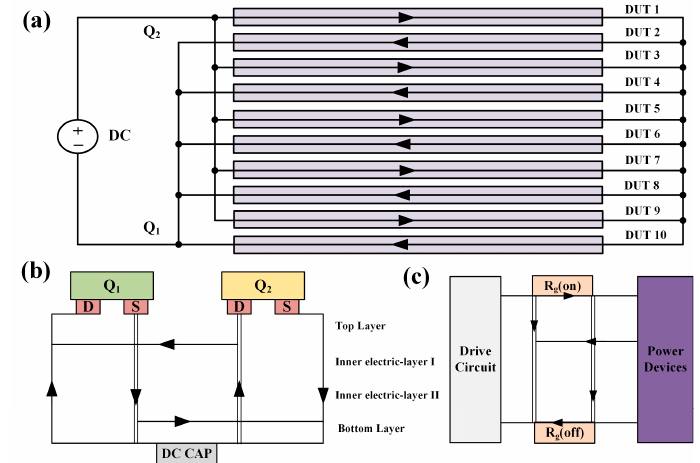
Figure 4. The design of PCB in: ( a ) the vertical multi-loop layout for DUT1–DUT10; ( b ) the parallel power circuit layout; and ( c ) the single-channel drive circuit layout.